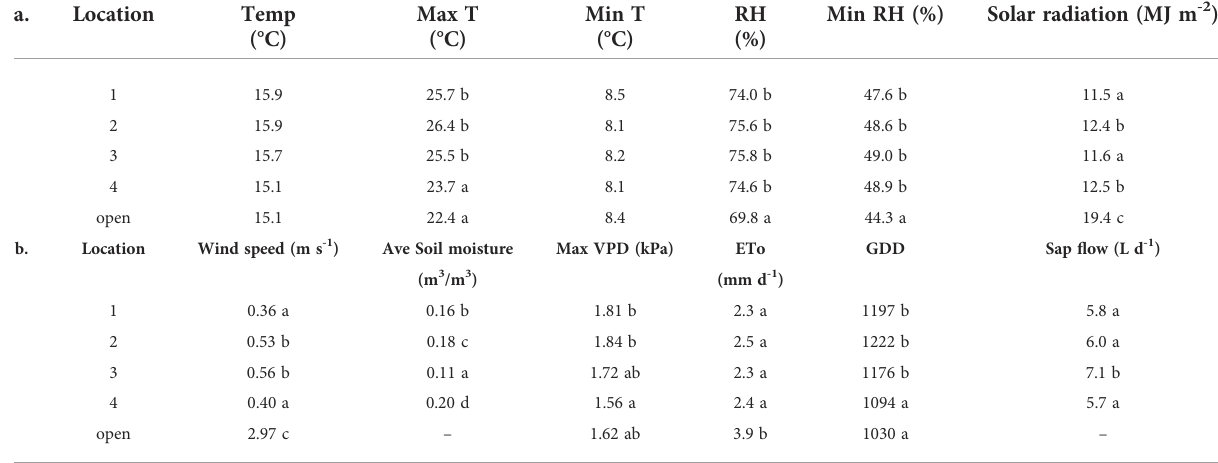
TABLE 3 Average daily climate data and sap fl ow over the season between October 17, 2020, and March 31, 2021, for location 1 (125 m asl, 105 m DFB), 2 (114 m asl, 75 m DFB), 3 (111 m asl, 60 m DFB), 4 (102 m asl, 50 m DFB) and in an adjacent open block.